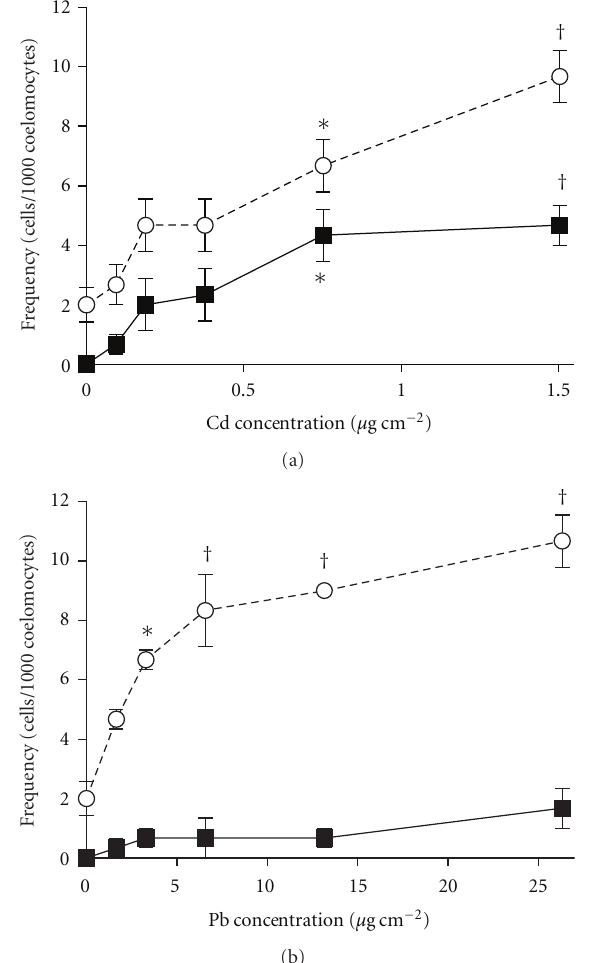
Figure 2: Micronuclei (black square) and binucleate cell (white circle) frequency (mean ± SE) of Pheretima peguana coelomocytes exposed to (a) Cd and (b) Pb after 48-h. Significantly di ff erent from the control ( ∗ P < . 05; † P < .